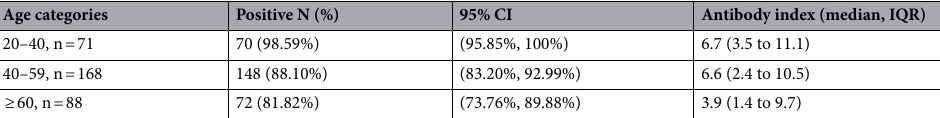
Table 1. Seroconversion rates and antibody titres (given as the antibody index) 4 weeks following a single dose of the